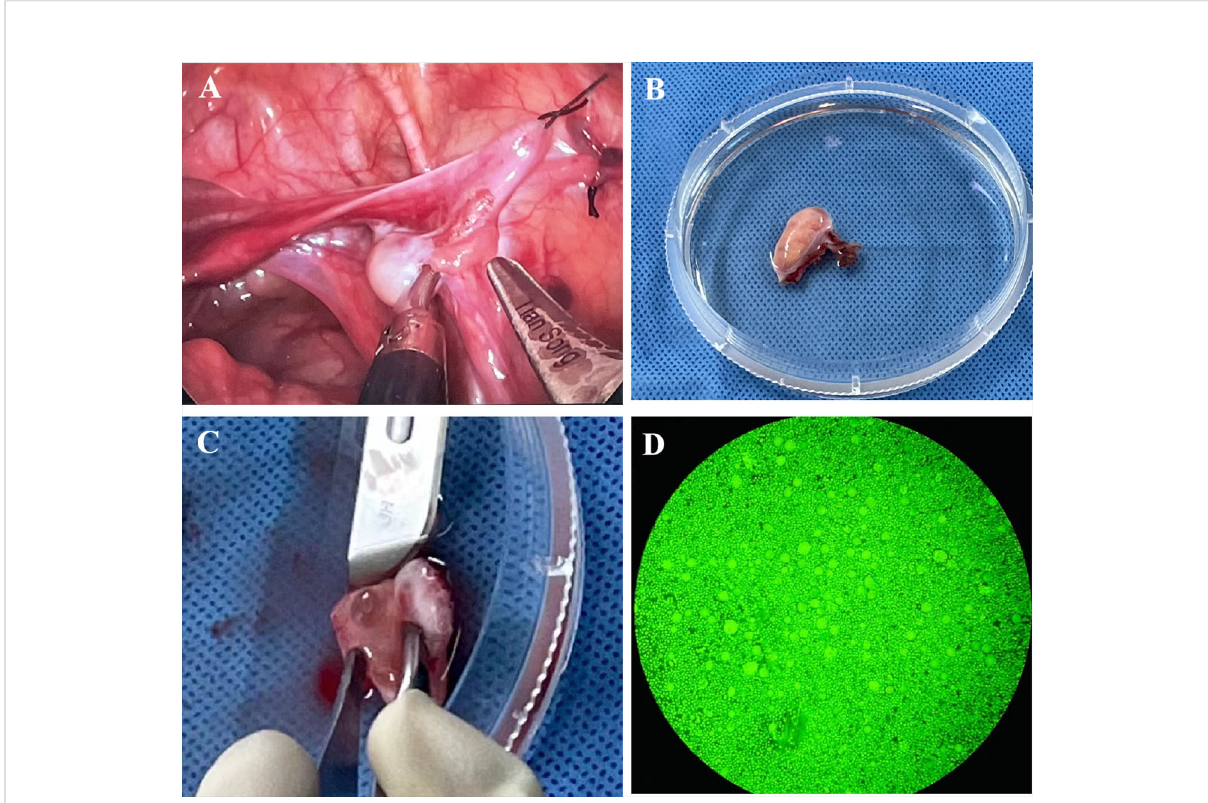
FIGURE 1 (A) Photos of the ovary during ovarian tissue biopsy; (B) Ovarian tissue was transported to ovarian tissue cryobank for ovarian tissue preparation; (C) An antral follicle can be seen during ovarian tissue preparation; (D) Detection of follicular activity in ovarian